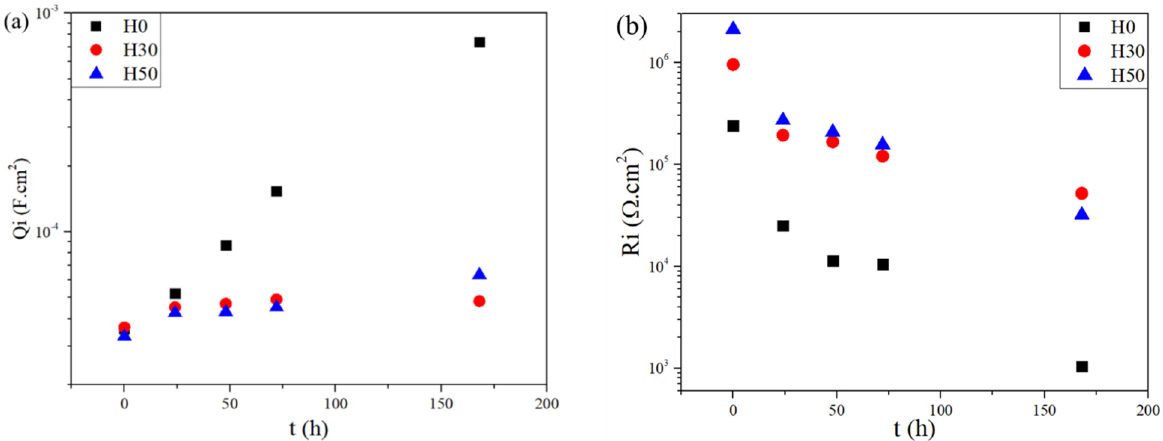
Figure 13. Evolution of ( a ) constant phase elements (CPE) value of the interface Q i and ( b ) its resistance R i during immersion in 0.05 M NaCl, calculated using equivalent circuits modelling.